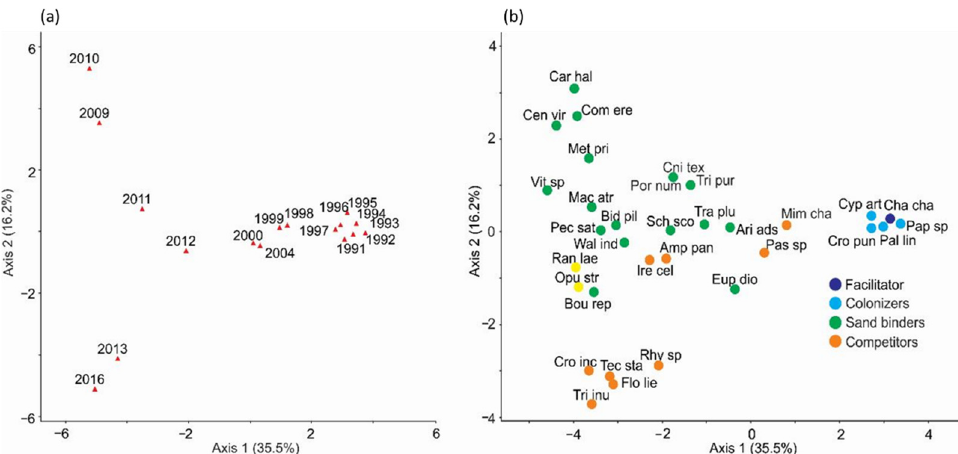
Figure 2. Principal component analysis biplots showing temporal changes in species abundance and community composition over the years during a 25-year successional sequence on mobile coastal dunes in Veracruz, located in the central region of the Gulf of Mexico. ( a ) Site scores; ( b ) species loadings. Red triangles show the location of site scores (years) in the ordination space. Successional groups and complete species names are shown in Table 1.